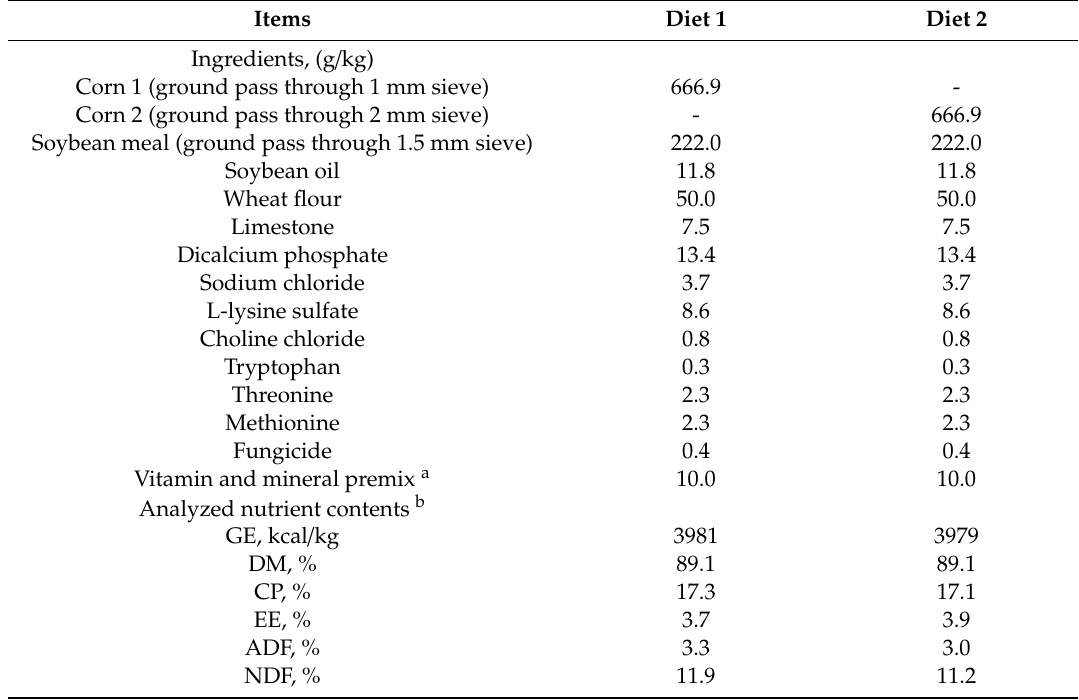
Table 1. Ingredients and chemical composition of the experimental diets (as-fed basis). Items Diet 1 Diet 2 Ingredients, (g /